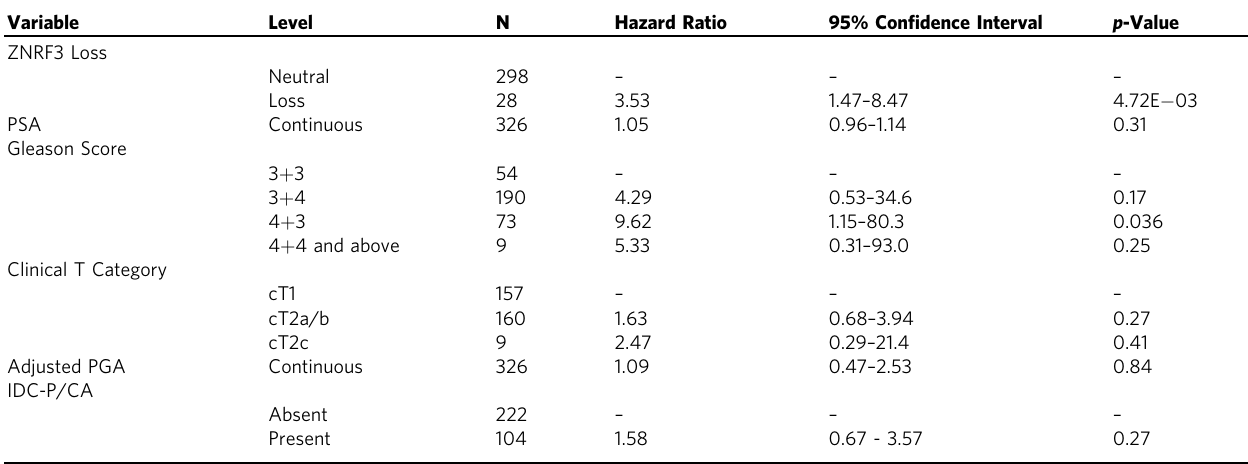
Table 1 Multivariable Cox proportional hazards model of ZNRF3 loss on metastatic relapse, corrected for clinical prognostic factors, adjusted PGA, and